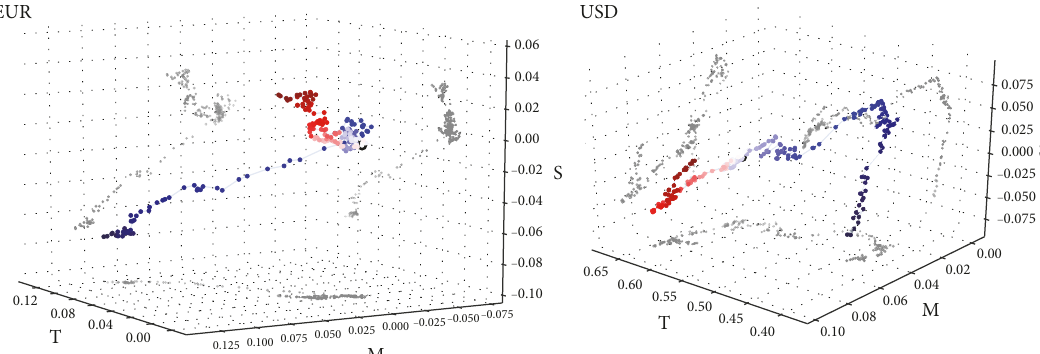
Figure 5: 200 time points showing the progression of the three information features memory (M), transfer (T), and synergy (S) computed with a time delay of 1 day (similar to 𝑡 = 1 for ECA). The color indicates the time difference with September 15, 2008 (big black dot), which we take as the starting point of the 2008 crisis, from dark blue (long before) to dark red (long after) and white at the crisis date. The data spans more than twelve years: the EUR data from January 12, 1998, to August 12, 2011, and the USD data from April 29, 1999, to June 6, 2011. Mutual information is calculated using a sliding window of 𝑤 = 1400 days; the 200 windows partially overlap and are placed uniformly over the dataset, where the first and last window include the first and last day of the dataset, respectively. The gray plus signs are the projections of the 3D points on the visible side faces for better visibility of the positions of the points.